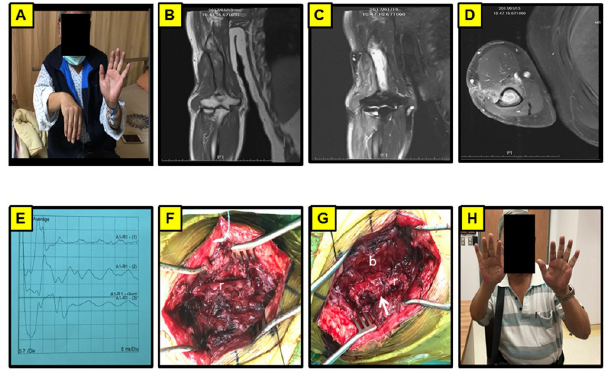
Fig 1. Representation of a right humerus fracture after ORIF complicated with osteomyelitis. (A) 68-year-old male presented with right wrist drop for 6 months after humerus fracture after operation. (B) MRI of right upper limb in T1W1 in coronal view. (C) MRI of right upper limb in T1W1 with contrast administration in coronal view. (D) MRI of right upper limb in T1W1 with contrast administration in axial view. (E) Intraoperative recording of CMAP stimulated from the distal to proximal end of the nerve. (F) The photography showed intact nerve but with severe fibrotic change. (G) Rotation of the muscle flap to wrap the injured region. (H) The patient showed favorable neurological outcome with restoration of wrist function 2 months after the operation. b: biceps muscle; r: radial nerve.